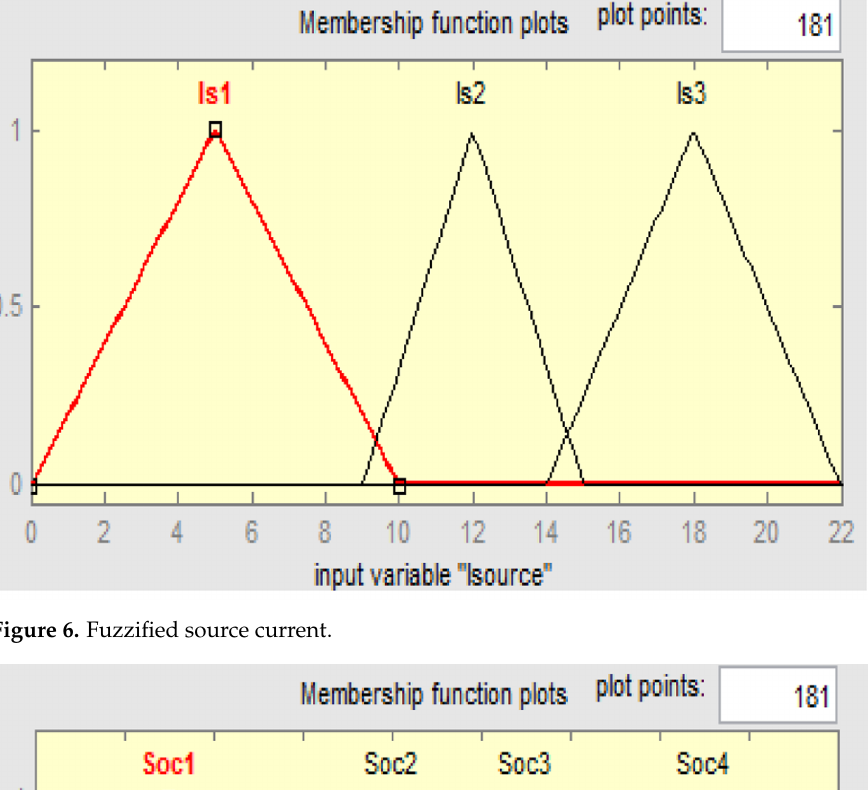
Figure 6. Fuzzified source current.